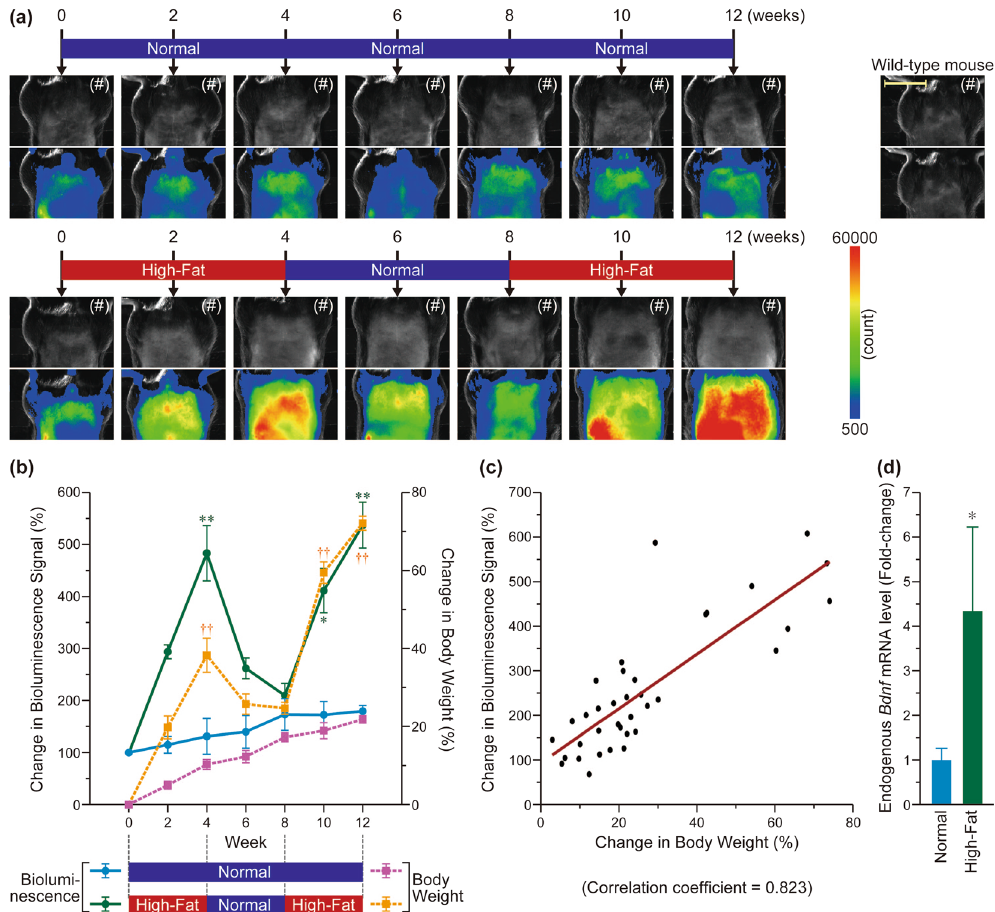
Figure 6. Strong correlation between the increase in body weight and bioluminescence signal under normal or high-fat diet in Bdnf - Luc Tg mice. ( a ) Representative images of the bioluminescence signal of Bdnf - Luc Tg mice under normal or high-fat diet. Imaging was performed with d-luciferin because it was sufficient to measure the changes in the signal from the abdominal region, which probably emanated from subcutaneous adipose tissues. In the normal diet group, we fed the normal diet to Tg mice continuously. In the high-fat diet group, we fed the high-fat diet to the mice for 4 weeks, and then the high-fat diet was changed to the normal diet. Four weeks after the change, we fed the high-fat diet to the Tg mice again. We also confirmed that the bioluminescence signal was not detected in the abdominal region of wild-type mice. Scale bar = 20 mm. The photograph of the abdominal region (indicated by (#)) was merged with the pseudocolored image. ( b ) Changes in the bioluminescence signals (circle) and body weight (square) of normal diet (light blue or pink) or high-fat diet (green or orange)-fed Bdnf - Luc Tg mice. The data represent the mean ± S.E.M. (n = 3). * p < 0.05, ** p < 0.01, and †† p < 0.01 versus normal diet-fed Tg mice. ( c ) The results shown in ( b ) were plotted, and statistical analysis was performed using Pearson’s correlation coefficient test ( rs = 0.823, p < 0.001). ( d ) After the last measurement of the bioluminescence signals (12 weeks), subcutaneous adipose tissues of each Tg mouse were isolated and total RNA was extracted by TRIsure. Then, the expression levels of endogenous Bdnf mRNA was examined by real-time PCR analysis. The data represent the mean ± S.E.M. (n = 9). * p < 0.05 versus normal diet-fed